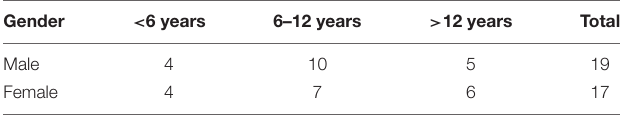
TABLE 1 | Gender and age characteristics of subjects.